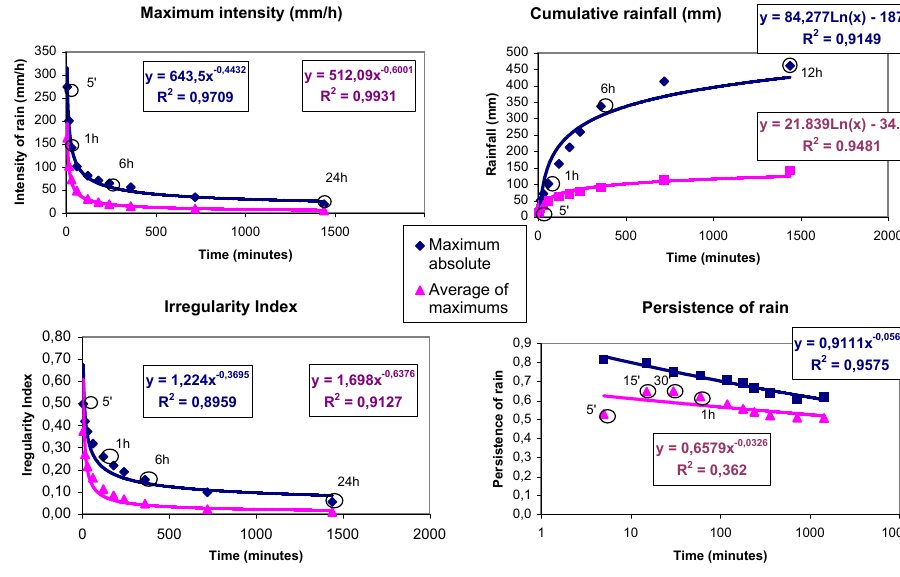
Fig. 2. Rainfall indicators of Maximum Intensity, Cumulative Rainfall, Irregularity and Persistence of Rain.